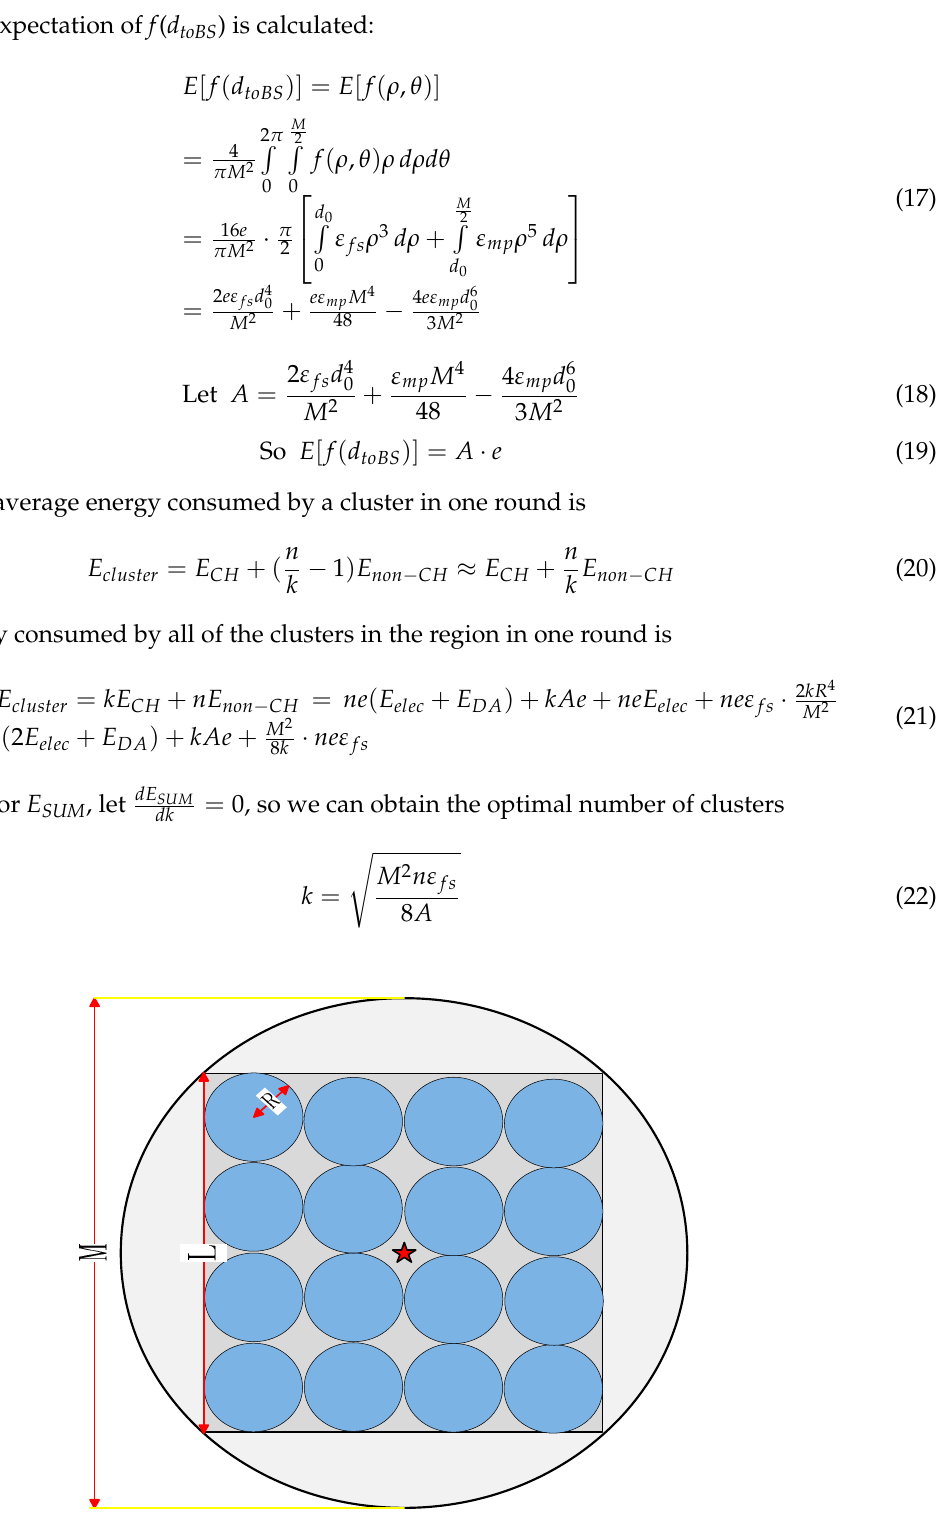
Figure 3. Network structure model diagram (16 clusters).